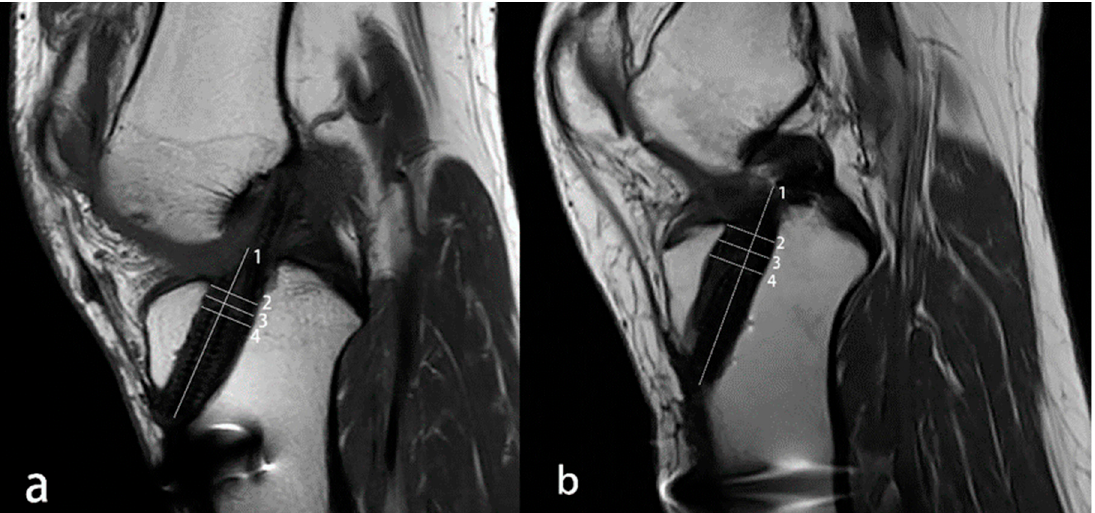
Figure 4. Sagittal T1-weighted MRI was used to measure the anteroposterior diameter of the tibial tunnel. ( a ), the patient's tibial interference screw is located in the front of the tunnel. ( b ), the screw is at the back of the bone tunnel. Line 1 is parallel to the bone tunnel, and lines 2, 3, and 4 are perpendicular to line 1. Line 2 is located at the level of the joint line, line 4 is at the level of the top of the screw, and line 3 is in the middle of lines 2 and 4. The tunnel enlargement rate was calculated as follows: TER (joint line level, center level, top of screw level) = (line 2, 3 or 4 − Drilled diameters)/(Drilled diameters) × 100%.